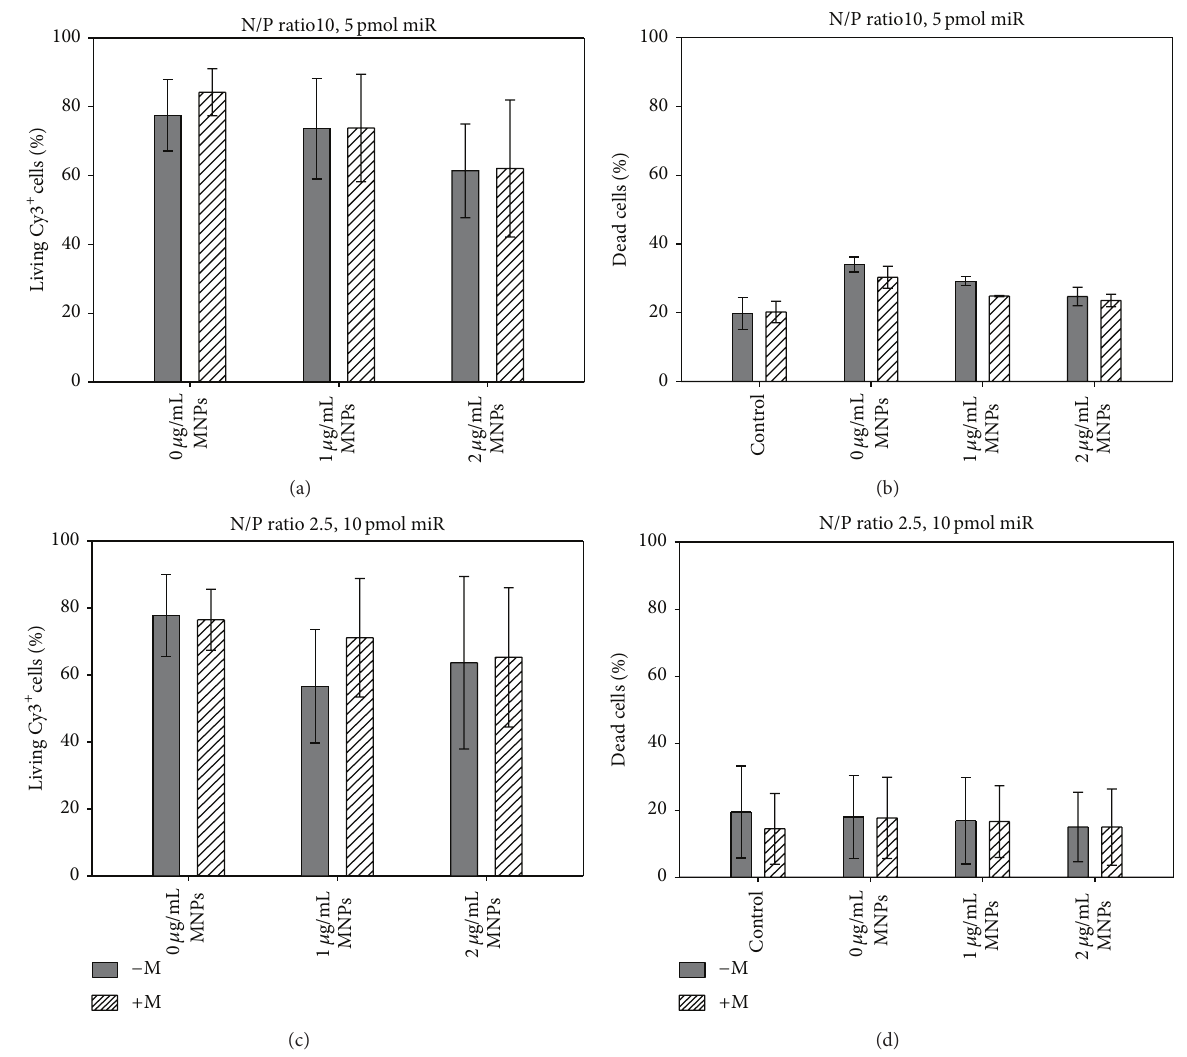
Figure 3: Transfection optimization of miR/PEI/MNP complexes. ((a)–(d)) Optimization of MNP amounts for transfection of freshly isolated hMSCs with (+M) and without ( − M) the application of a magnetic field. hMSCs were transfected with Cy3-labeled miR/PEI and miR/PEI/MNP complexes composed of an N/P ratio of 10 combined with 5 pmol miR ((a), (b)) or an N/P ratio of 2.5 combined with 10pmol miR ((c), (d)) and three different MNP amounts (0, 1, or 2 𝜇 g/mL MNPs). 24 hours after transfection, uptake efficiency ((a), (c)) and cytotoxicity ((b), (d)) of complexes were analyzed by flow cytometry. Untransfected cells were used as control. Values are presented as mean ± SEM; 𝑛 = 3